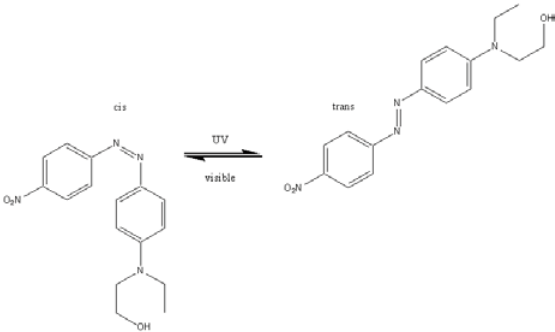
Figure 1. DR1 cis-trans